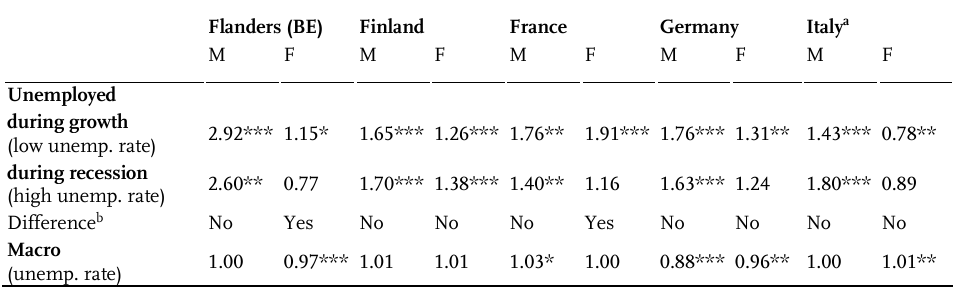
Table 3 : Interaction effects, discrete-time models of the dissolution risk for men (M) and women (F), odds ratios Flanders